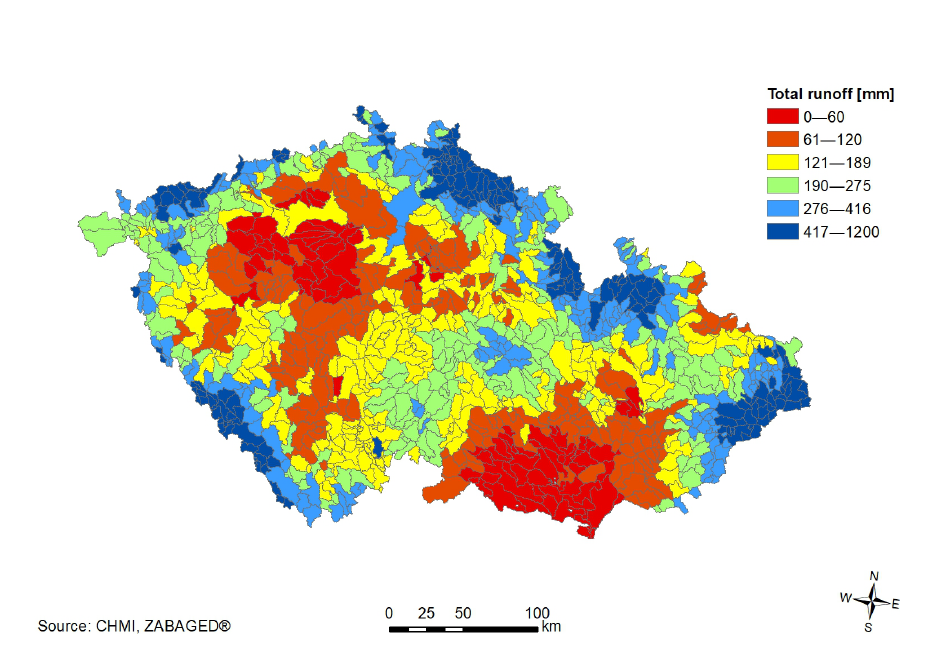
Figure 2. Spatial distribution of average annual runoff height of water surface bodies in the Czech Republic for the reference period